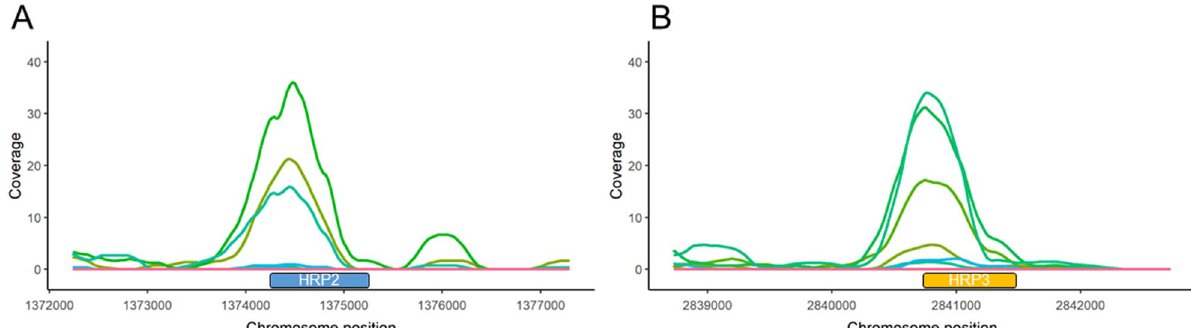
Figure 3. Read depth on pfhrp2 and pfhrp3 for all samples. ( A ) Three samples presented coverage for the pfhrp2 gene. ( B ) Four samples presented coverage for the pfhrp3 gene. None of the Bv1-type samples presented coverage on pfhrp2 nor pfhrp3 . The y-axis denote read depth whereas the x-axis indicates the nucleotide position in base pairs in chromosomes 8 ( A ) and 13 ( B ), respectively. Pfhrp2 and pfhrp3 gene positions are showed as boxes on the x-axis. In order to facilitate visualization, read depth was plotted using a sliding window of 500 bp and samples with coverage along the gene have been plotted as green shade colored lines.